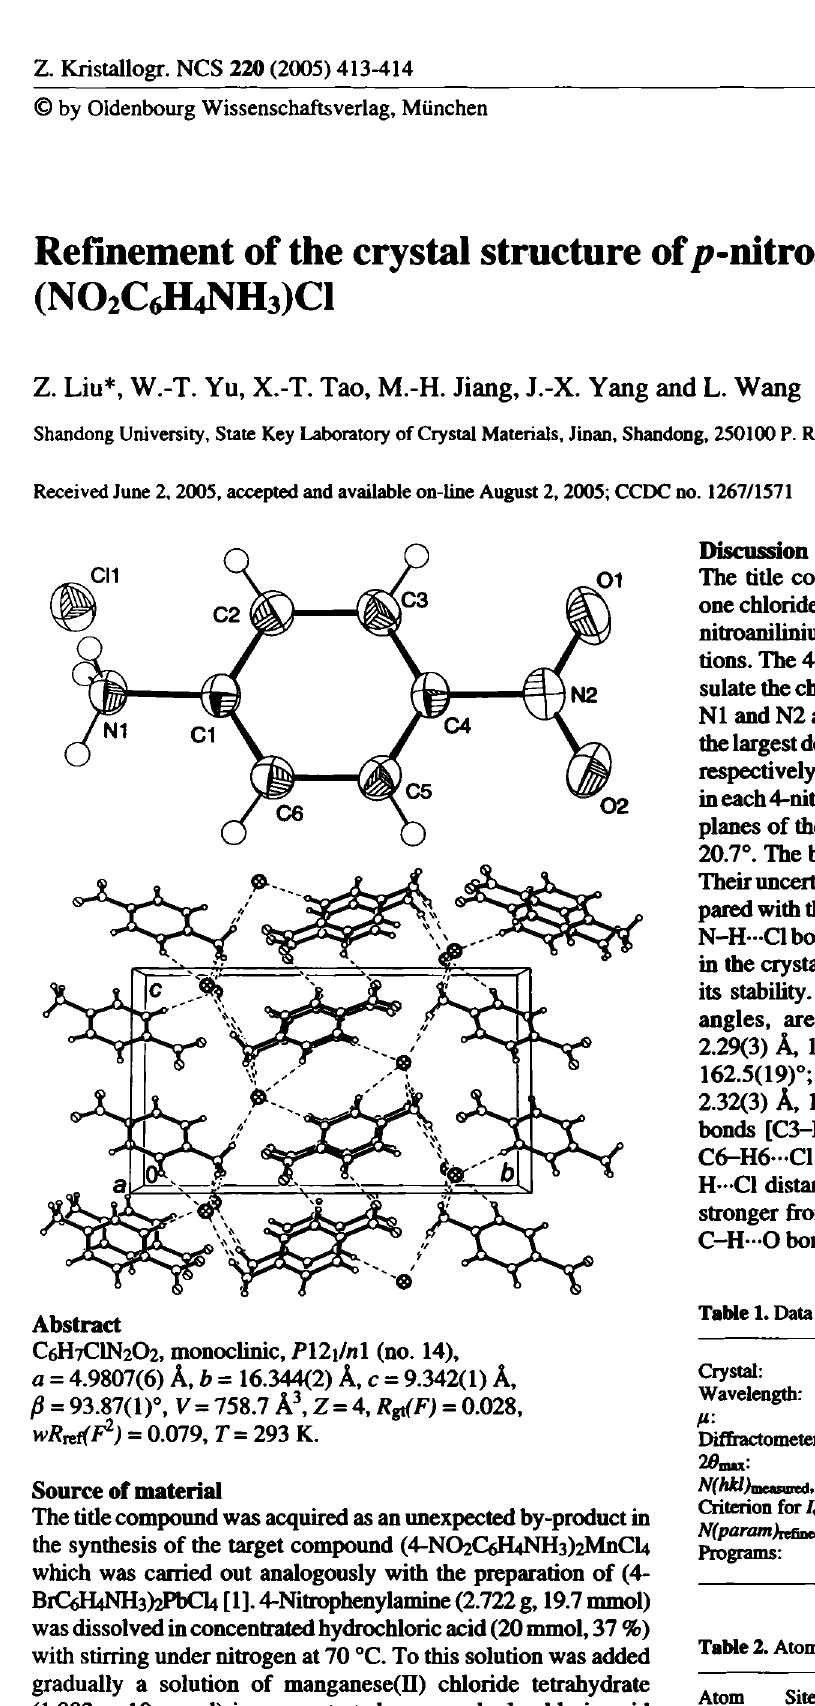
Table 2. Atomic coordinates and displacement parameters (in A 2